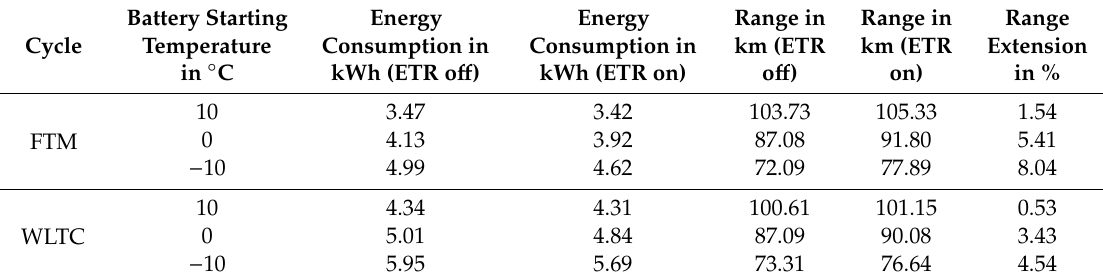
Table 1. Driving ranges and range extensions for di ff erent battery starting temperatures and a fully charged battery (starting state of charge, SoC Start = 86.8%) for the WLTC and the FTM